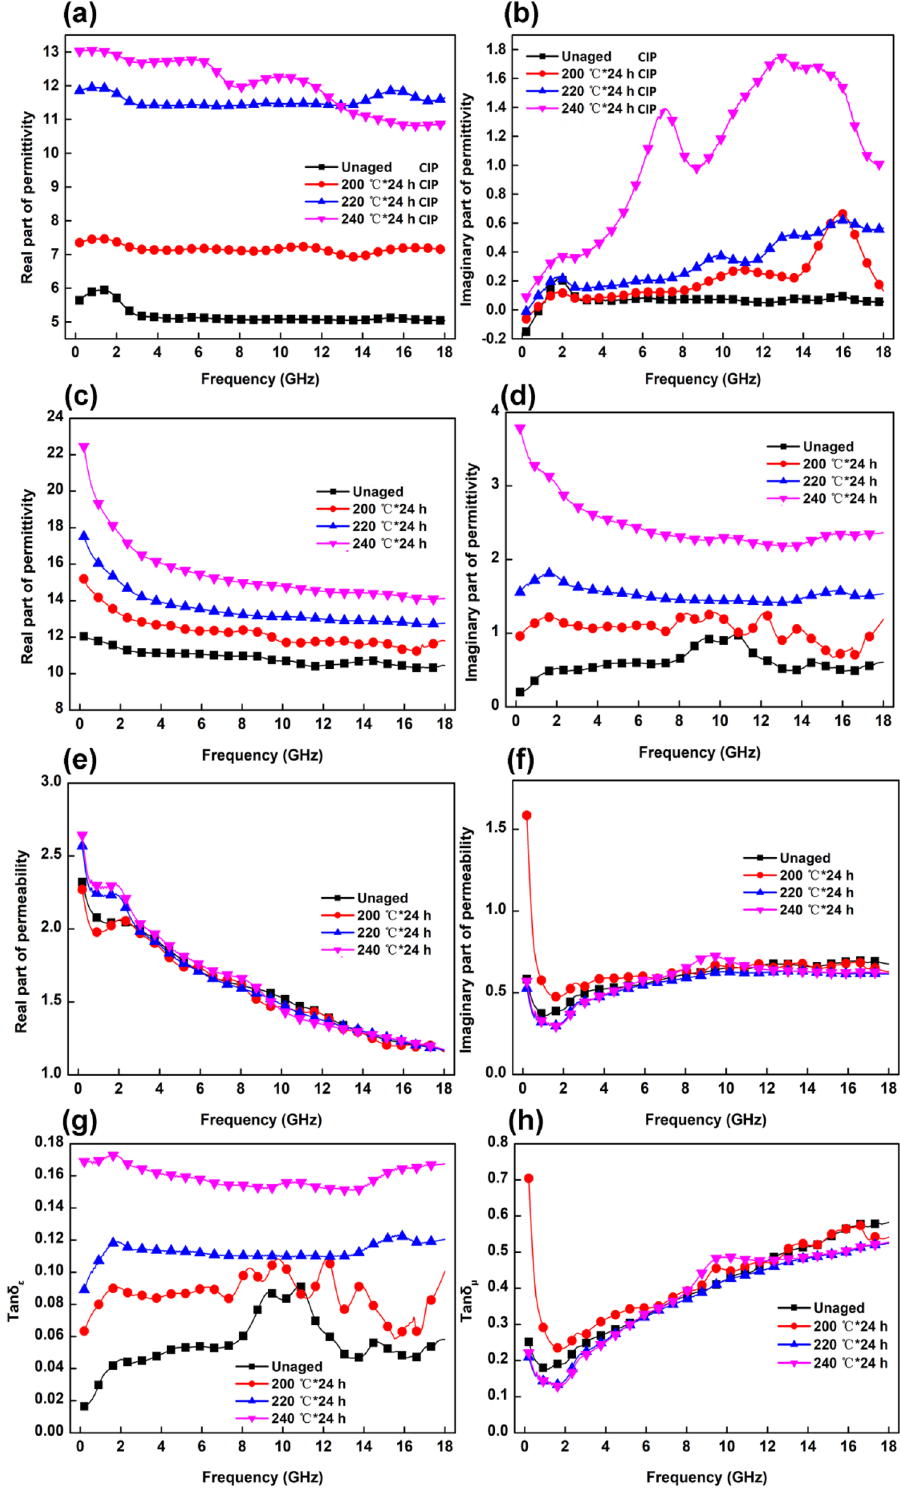
Figure 6. ε ′ ( a ) and ε ″ ( b ) values of CIPs aged at the different temperatures; electromagnetic parameters of the composites aged at the different temperatures: ε ′ ( c ), ε ″ ( d ), μ ′ ( e ), μ ″ ( f ), tan δ ε ( g ), and tan δ μ ( h